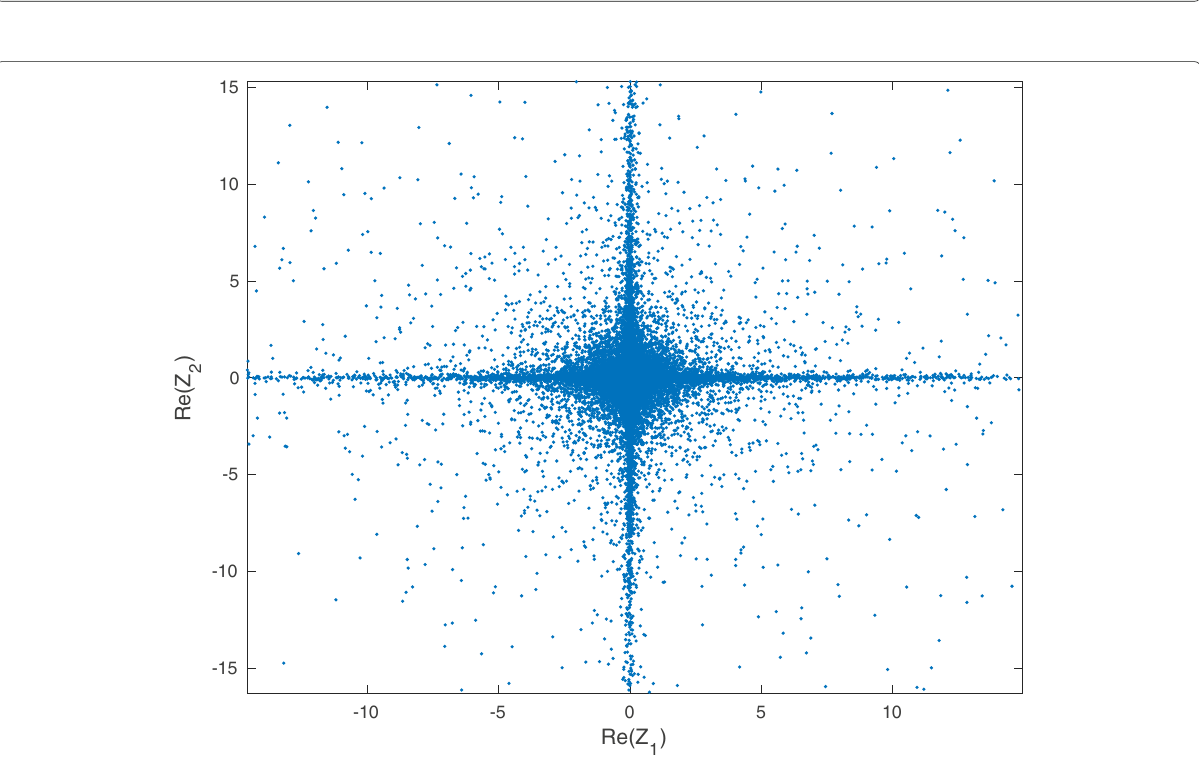
Fig. 2 Scatter plot of samples from the real parts of interference drawn from two distinct bands, b 1 , b 2 . Samples generated from a network of devices using a disjoint SCMA codebook. Bands b 1 , b 2 lie in the same disjoint subset. The distribution of devices is the same as Fig. 1